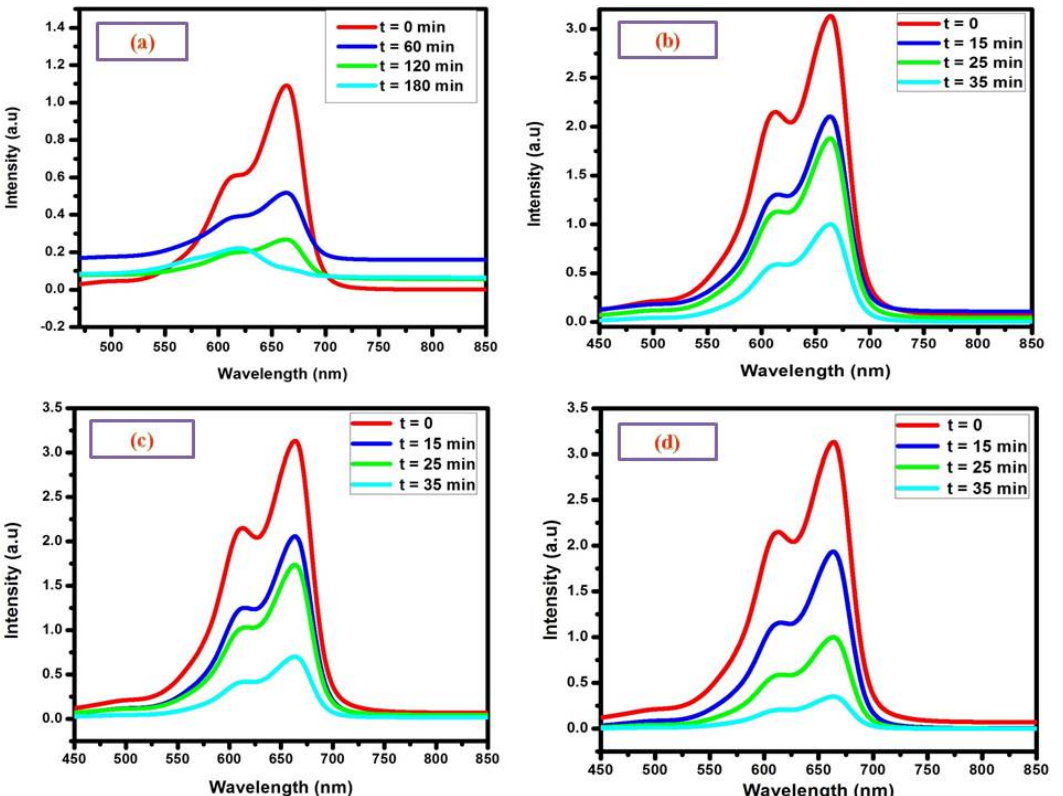
Fig. 8. Absorption spectra of MB solution after degradation by (a) pure ZrO